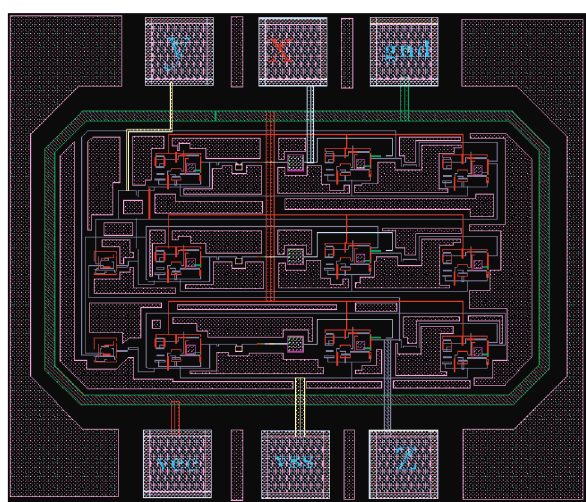
Figure 7: Chip layout diagram of the Chen chaotic oscillation circuit.